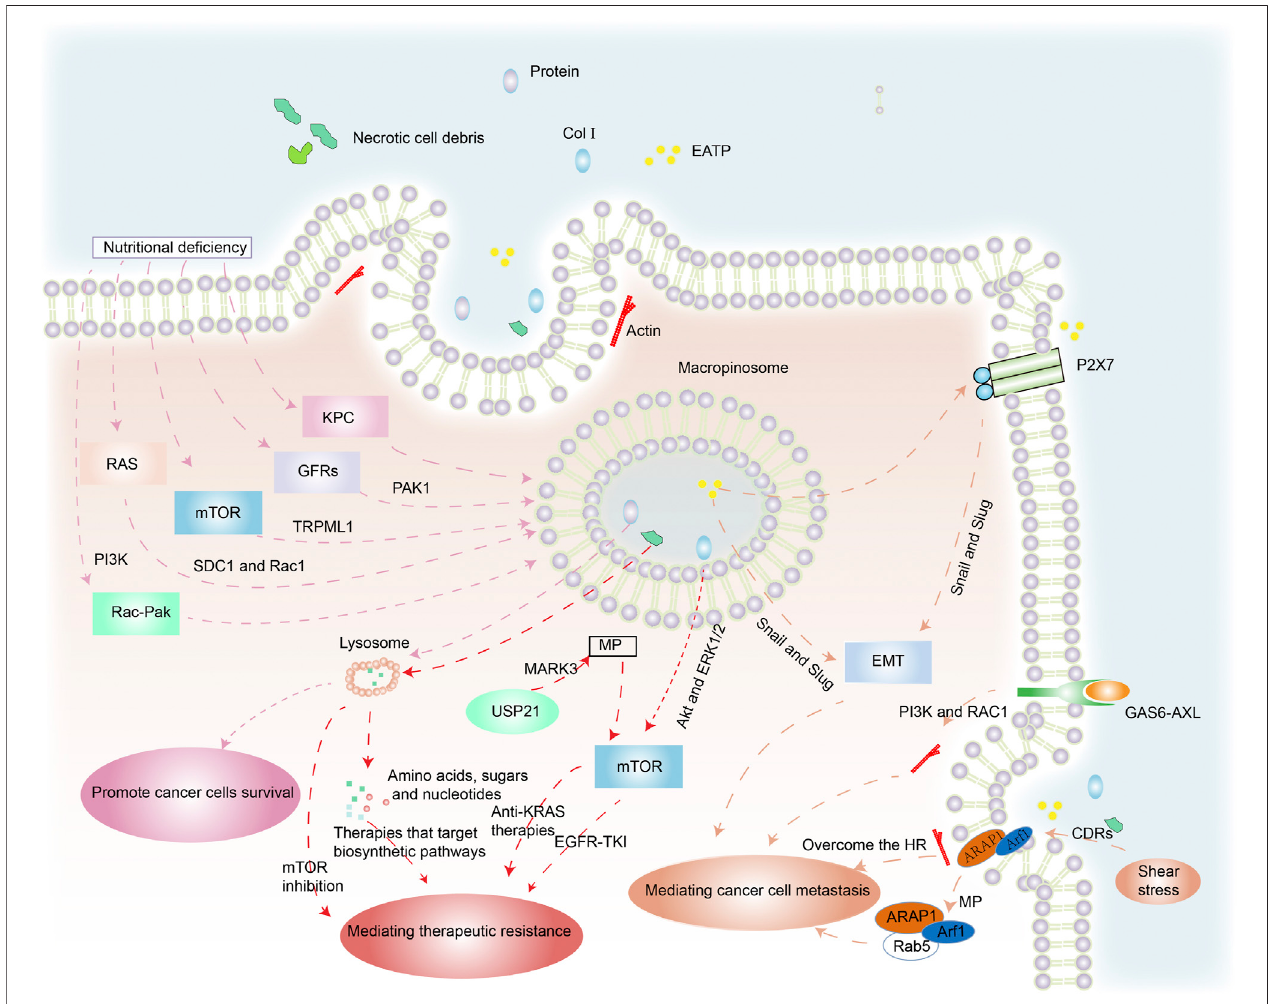
FIGURE 2 | The bene fi ts of macropinocytosis for cancer cells. (1) Under the pressures of nutrient de fi ciency, regulation of RAS genes, mTOR, GFRs and other factors triggers macropinocytosis in cancer cells. Macropinosomes fuse with lysosomes and foreign protein is degraded to amino acids that are released to enhance cancer survival. (2) Necrotic cell debris ingested by cancer cells acts against therapies that target biosynthetic pathways. USP21 promotes KRAS-independent tumor growth via macropinocytosis inducedbyMARK3, contrary toanti-KRAS therapies.Col Iisalsointernalized bymacropinocytosis, whichmediatesthe resistance of EGFR-TK1 by mTOR activation through Akt and ERK1/2 independent pathways. (3) EATP induces EMT via enhanced transcription factors Snail and Slug (and possibly others) and directly and indirectly accelerates cell migration and invasion. GAS6-AXL signaling induces PI3K- and Rac1-dependent, actin-driven cytoskeletal rearrangements and macropinocytosis that jointly promote cancer migration. Thepositionofcells insensitivetoHR mediated by macropinocytosis enhances their ability to metastasize. The stimulation of shear stress promotes ARAP1/Arf1 traf fi cking to support cancer cell migration.